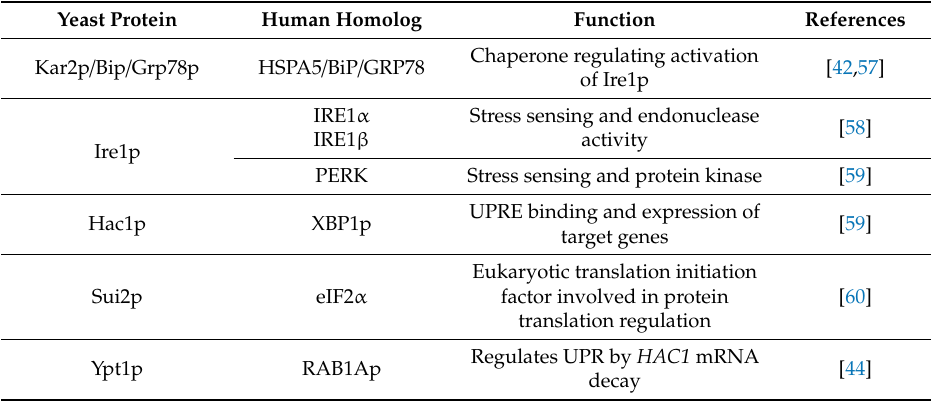
Table 1. Conserved proteins of yeast unfolded protein response and their human